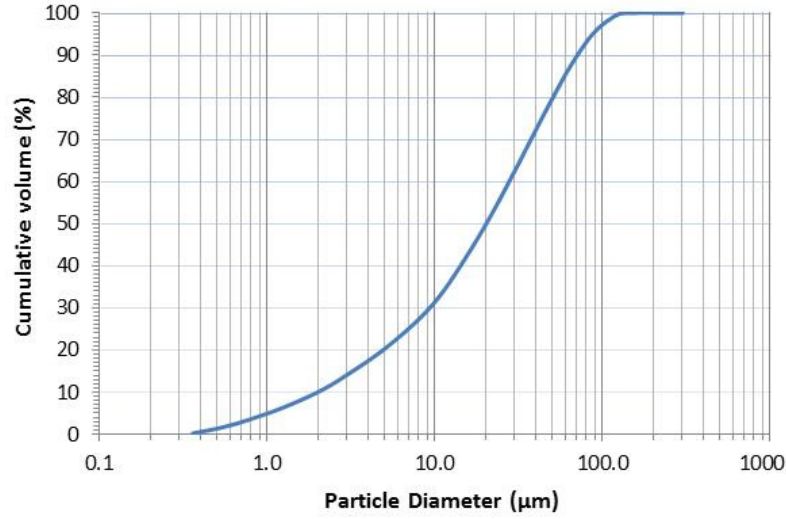
Figure 2. Particle size analysis of fly ash.